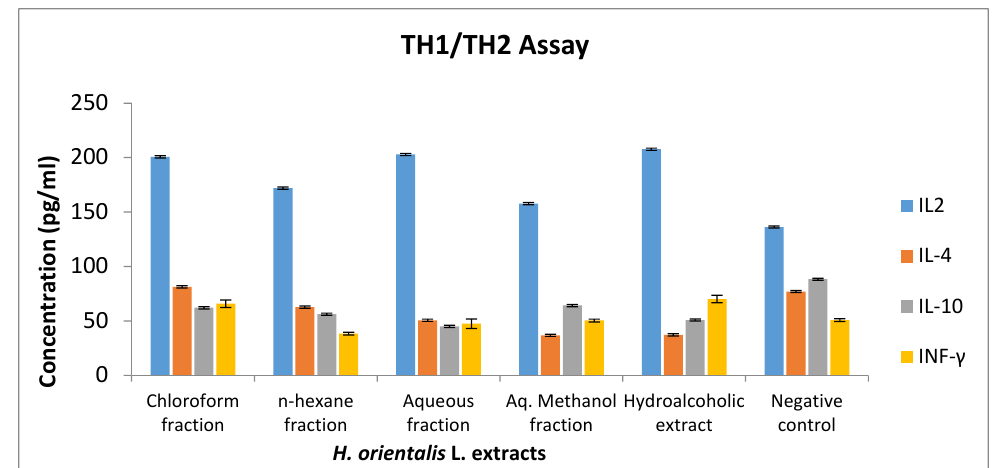
Figure 6. The effect of H. orientalis L. extract and fractions on IL-2, IL-4, IL-10, and IFN- γ level at concentration of 50 mg/mL. TH1/THI murine assay kit was used to measure the effect of the H. orientalis on cytokines. Secretion of IL-2 was enhanced in the presence of hydroalcoholic extract and chloroform fraction. Results are expressed as means of three independent experiments (bars) ± SEM (lines).